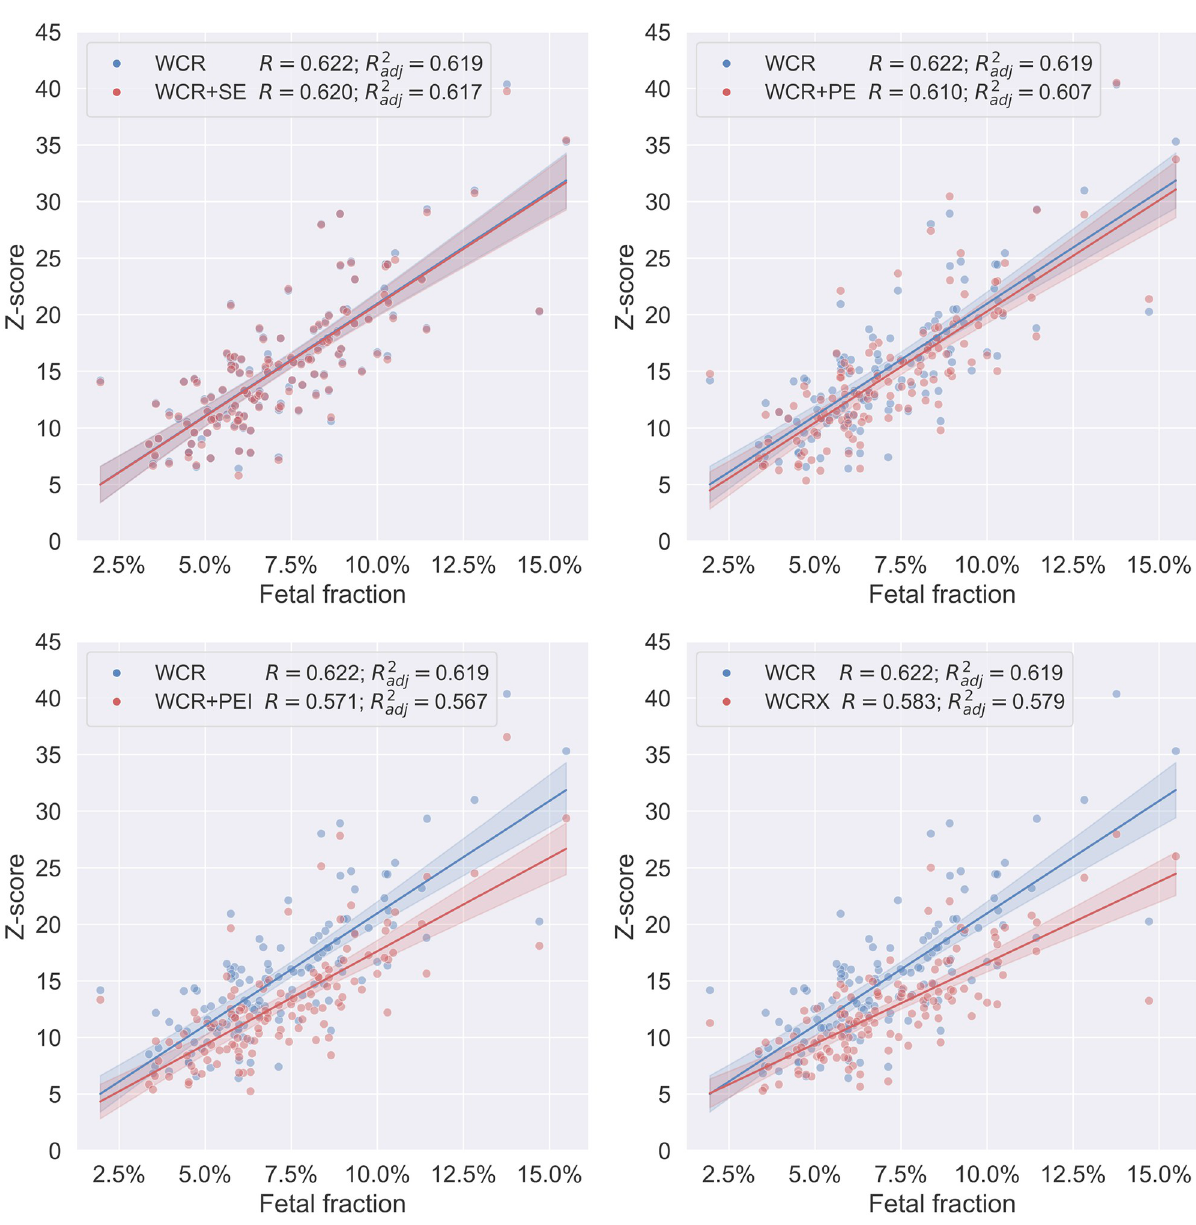
Fig 3. Event Z-scores relative to fetal fraction at 250 kb. All � 10 Mb events with Z-scores � 5 on chromosome 21, detected by the different methods for a 250 kb bin size in the T21 positive samples, relative to the estimated fetal fractions of each sample. Each plot compares one of the methods WCR +SE, WCR+PE , WCR+PEI , and WCRX (all in red) with WCR (in blue), and each point corresponds to an event within a sample. The legend annotation relates each method with the respective R value and adjusted R squared value of the linear